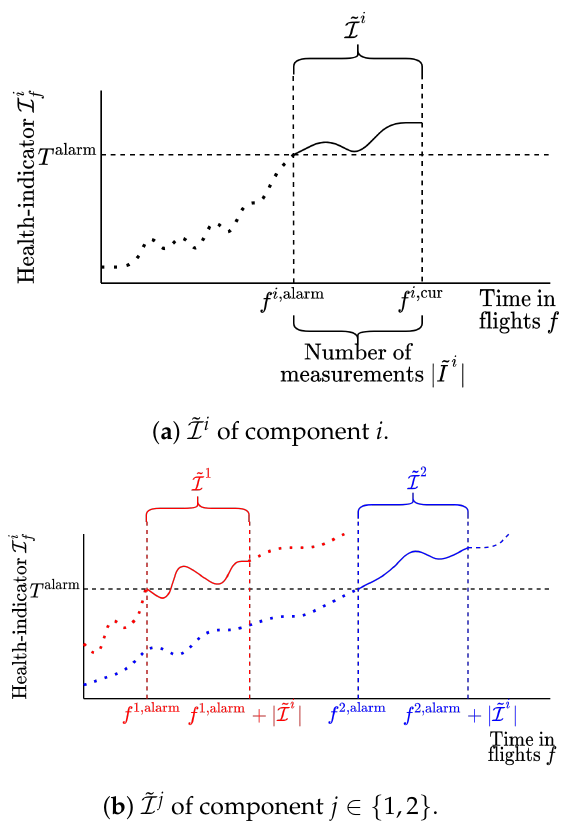
Figure 3. Illustration of online clustering for component i with partial health indicator ˜ I i . The library consists of run-to-failure data for components j ∈ { 1,2 } with partial health indicators ˜ I 1 and ˜ I 2